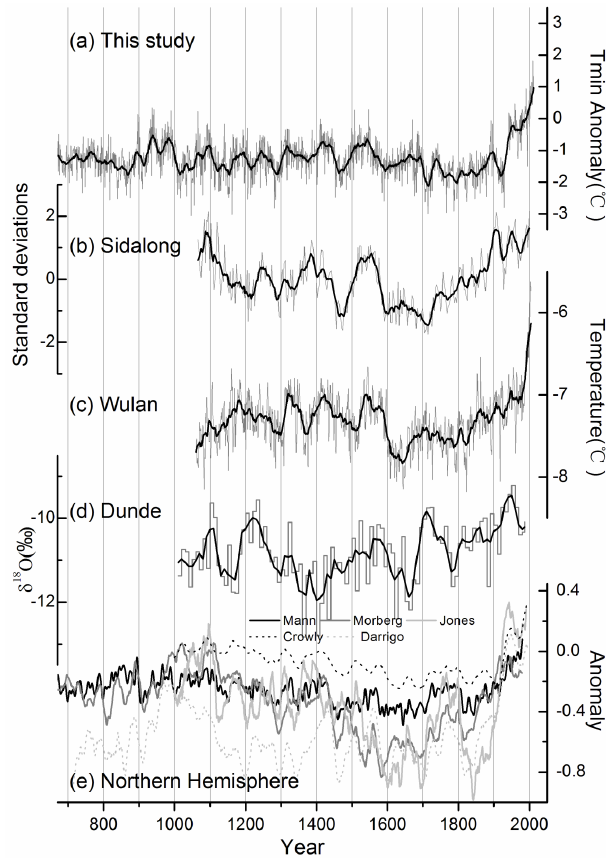
Fig. 9 Comparison between the reconstruction presented here (a) and other temperature series for the Qilian Mountains (b, c, and d) (Liu et al., 2007; Zhu et al., 2008; Thompson et al., 2003), and the Northern Hemisphere (e) (Jones et al., 1998; Mann et al., 1999; Crowly, 2000; Moberg et al., 2005; D’Arrigo et al., 2006). The dark lines indicate the 20-year running mean of each series except for the 21-year running mean of Sidalong series (Liu et al., 2007).